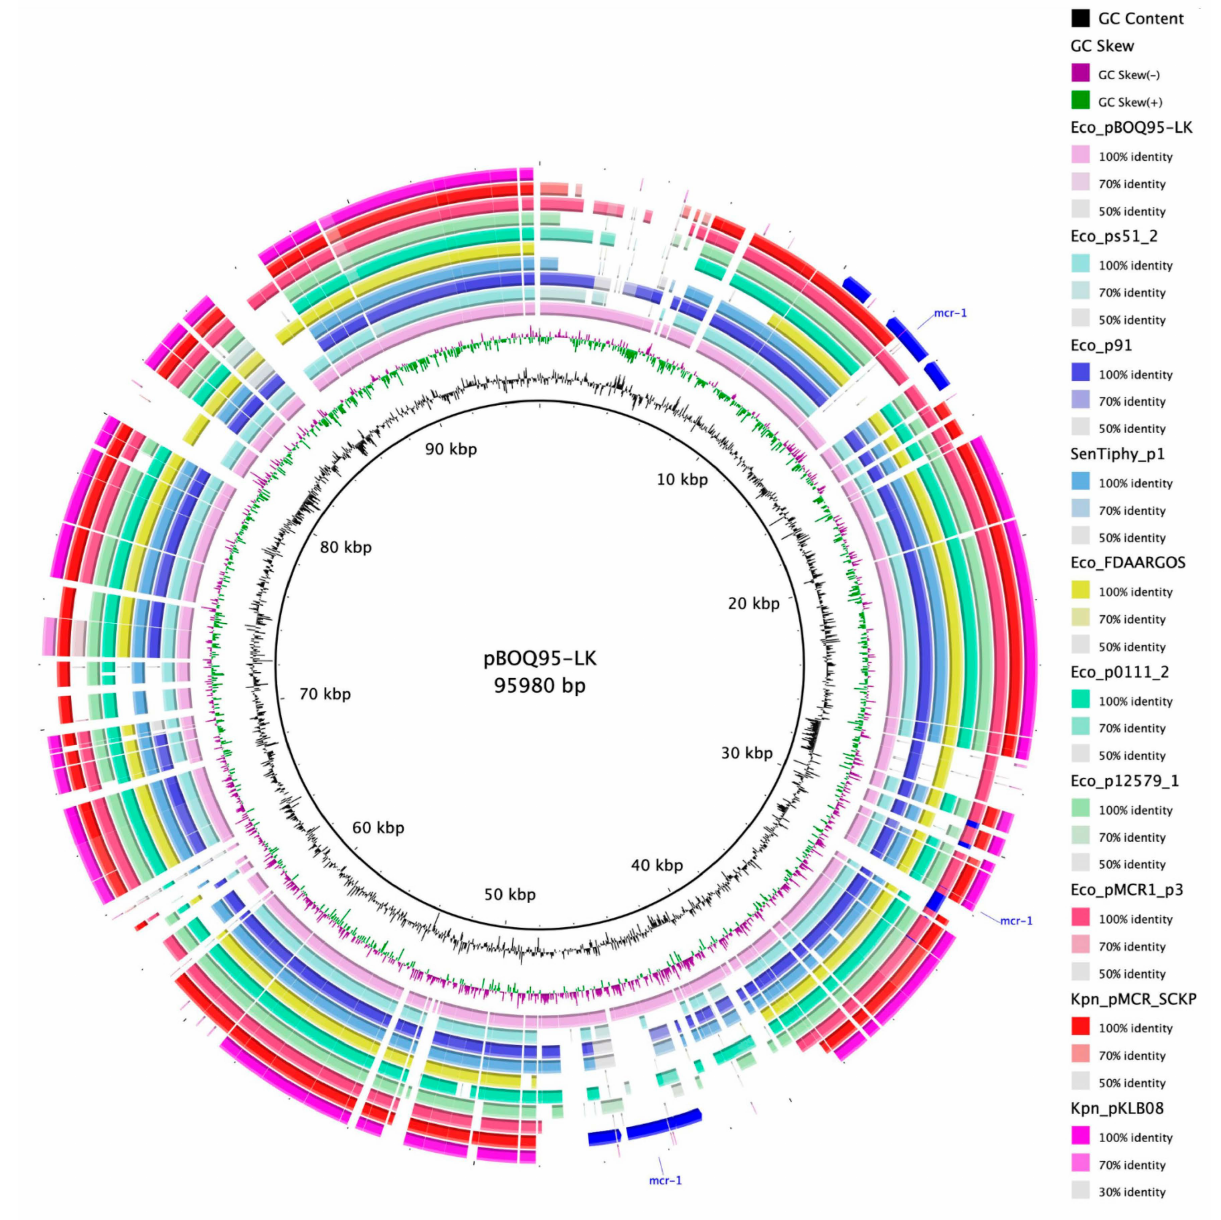
Figure 4. Circular comparison of plasmid pBOq-95LK (interior black line) with 9 phage-like plasmids. The BLAST Ring Image Generator (BRIG) program was used to align the plasmid pBOq-95LK with the other nine plasmids, and each sequence is represented in the concentric circles with color. The blue labels in the three external circles represent the location of the mcr-1 gene encoding for colistin resistance and the mobilization elements around this gene.